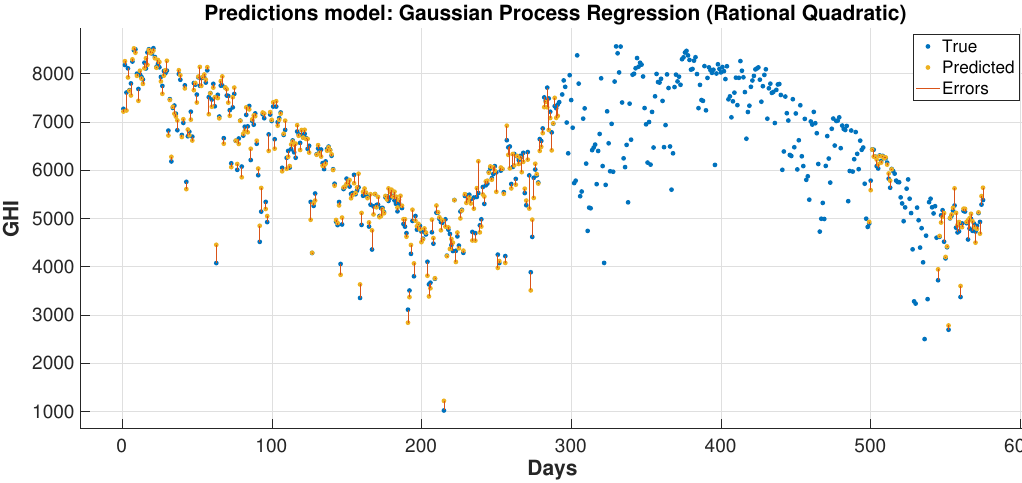
Figure 14. The predicted solar irradiance versus the real values for TU dataset without